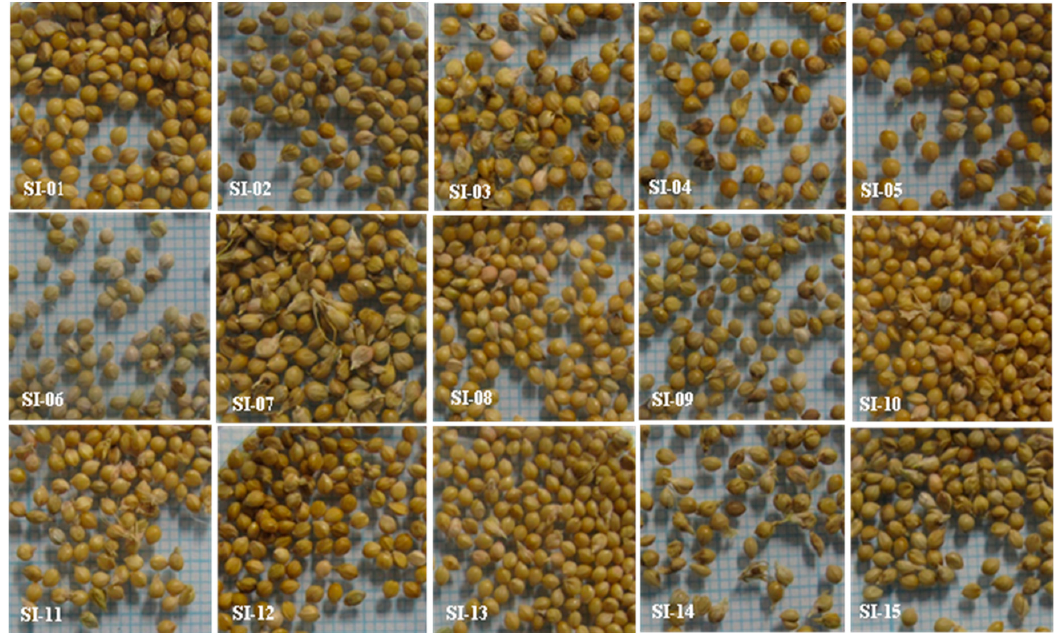
Figure 1. Variation in the seed morphology and color in the 15 accessions of S. italica .